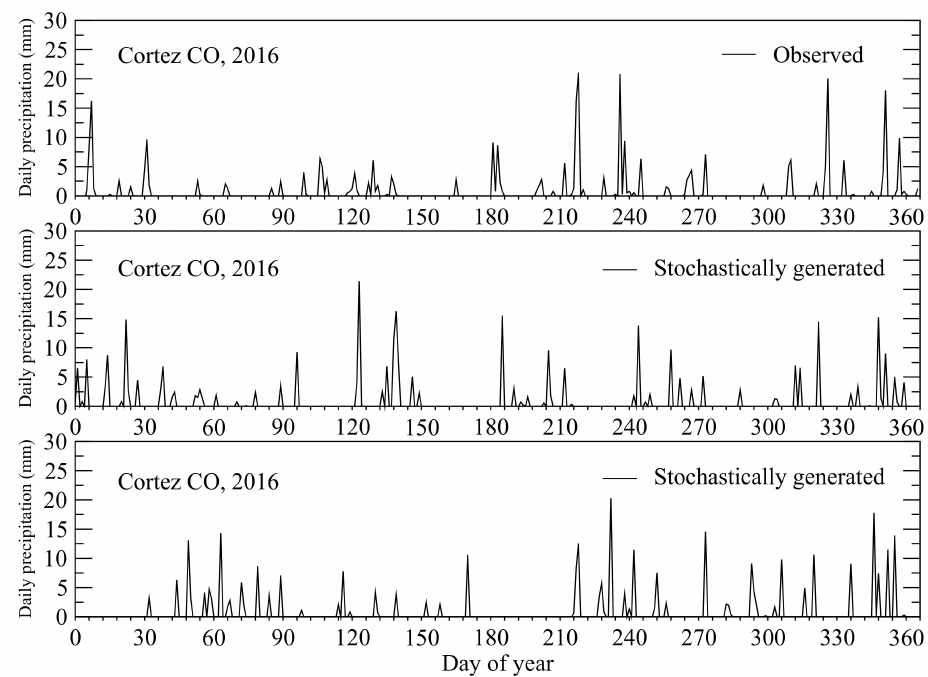
Figure 14. Observed and stochastically generated daily precipitations in year